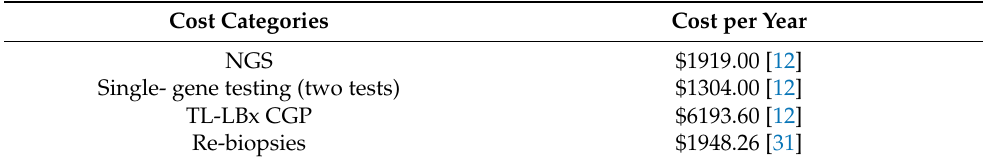
Table 5. Annual molecular genetic testing costs (per